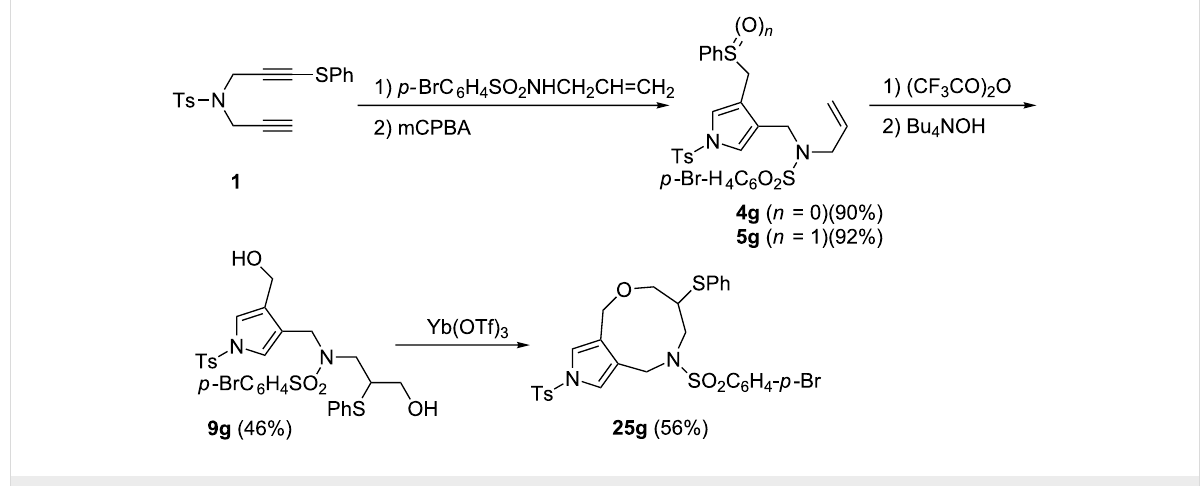
Scheme 7: Sequential process of sulfanyl-1,6-diyne 1 to 4 H -pyrrolo[3,4- g ]oxazine 25g .